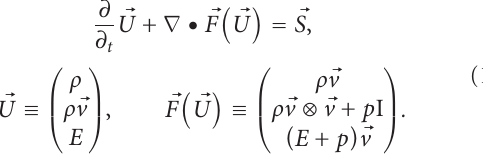
Figure 4: The strong shock flow configuration in Sajben